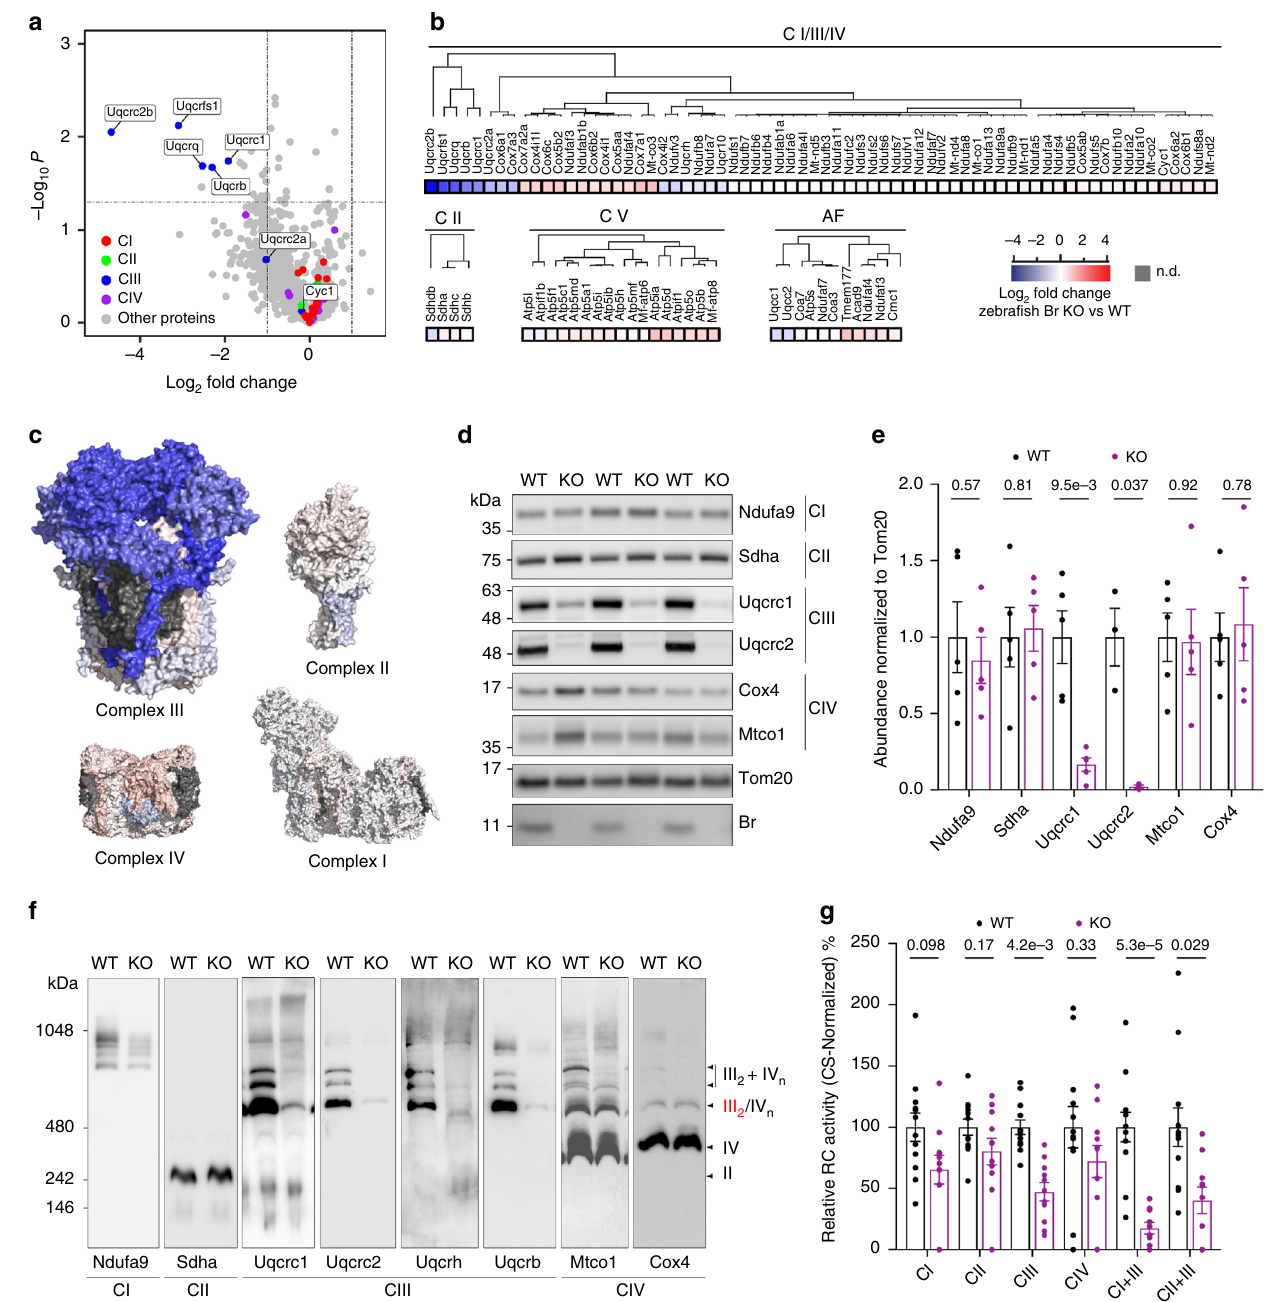
Fig. 6 Br is required for complex III assembly and activity. a Quantitative proteomic analysis of WT and br zKO isolated adult skeletal muscle (SKM) mitochondria. Mean values of log 2 fold change (zKO/WT) for each detected protein from three biological replicates are plotted in a volcano plot. Subunits of each of the ETC complexes are labeled in the indicated colors. CI – CV = Complex I – Complex IV. p -values from two-sided unpaired t -test. b The median log 2 fold change (zKO/WT) of all detected ETC proteins are further depicted in a dendrogram heatmap and separated by complex membership. AF = assembly factors. c The median log 2 fold change (zKO/WT) of CI – CIV proteins were superimposed onto the structures of human CI – CIV to visually depict the observed changes. The same scalebar from panel 6b applies. Undetected proteins are shown in gray. d SDS-PAGE of puri fi ed WT and zKO SKM mitochondria followed by immunoblotting for the indicated ETC proteins. Image is representative of two experiments. e Quantitation of SDS-PAGE in 6d. Data represent mean and SEM. n = 5, except for Uqcrc2 where n = 3. p -values from two-sided unpaired t -test. f BN-PAGE and western blot analysis of WT and zKO SKM mitochondria. Position of free III 2 (red) and III 2 + IV n (black) supercomplexes are indicated by arrowheads. g Spectrophotometric respiratory chain activity assay (RCA) of WT and zKO SKM mitochondria. Data represent mean and SEM. Each dot represents one animal, n = 12 for WT and zKO animals. p -values from two-sided unpaired t